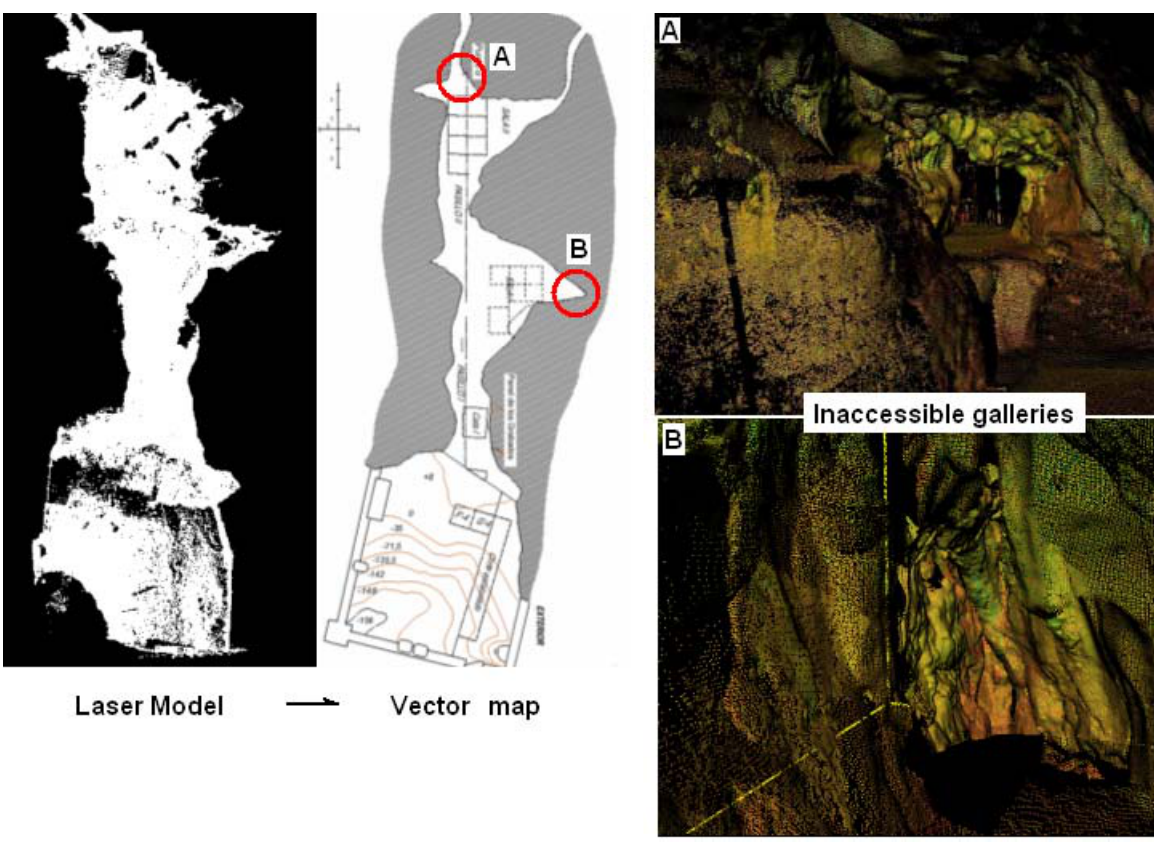
Figure 4. Left: Top view of the laser model at “Las Caldas” cave. Centre: Vector floor plan extracted from laser scanner dataset. Right: Inaccessible galleries recorded with